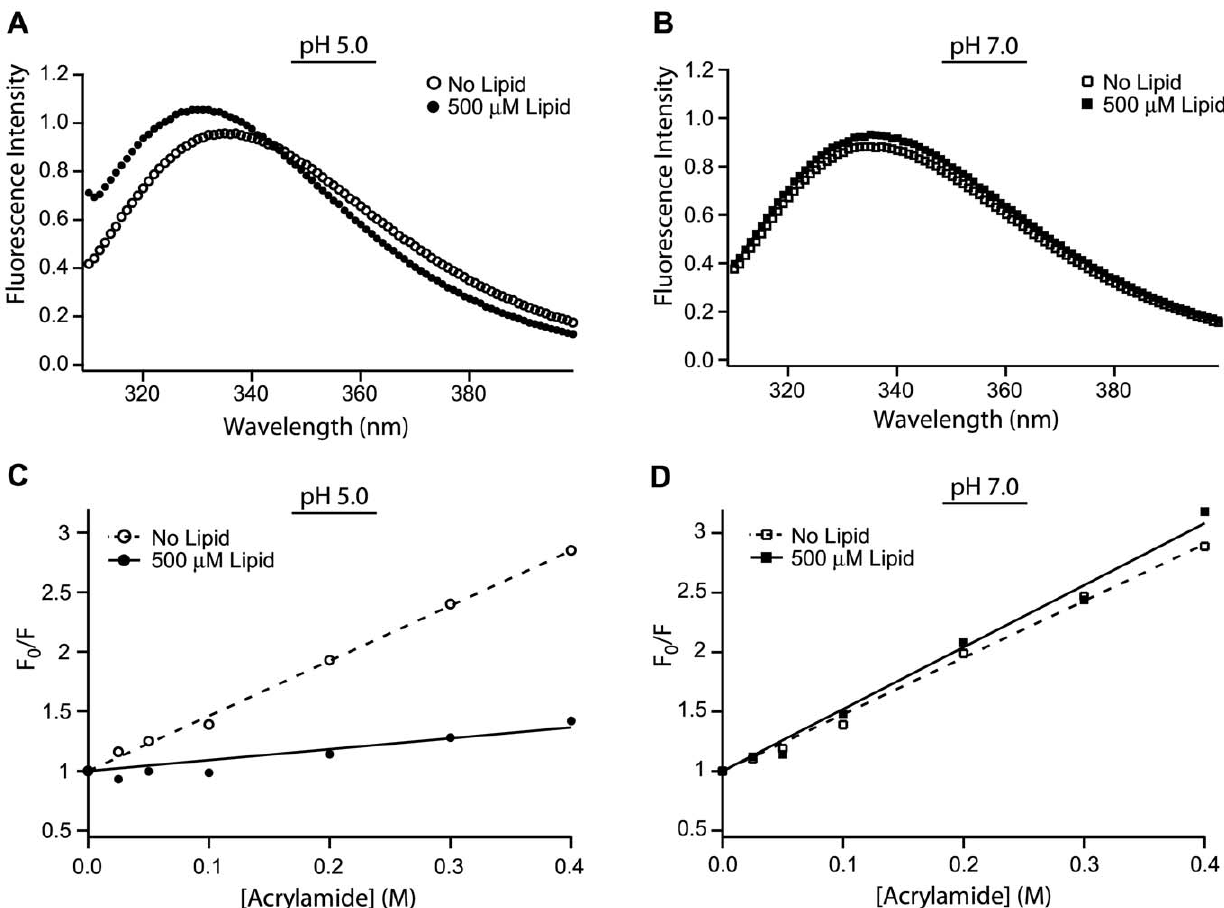
N ) or absence ( # ) of lipid vesicles at